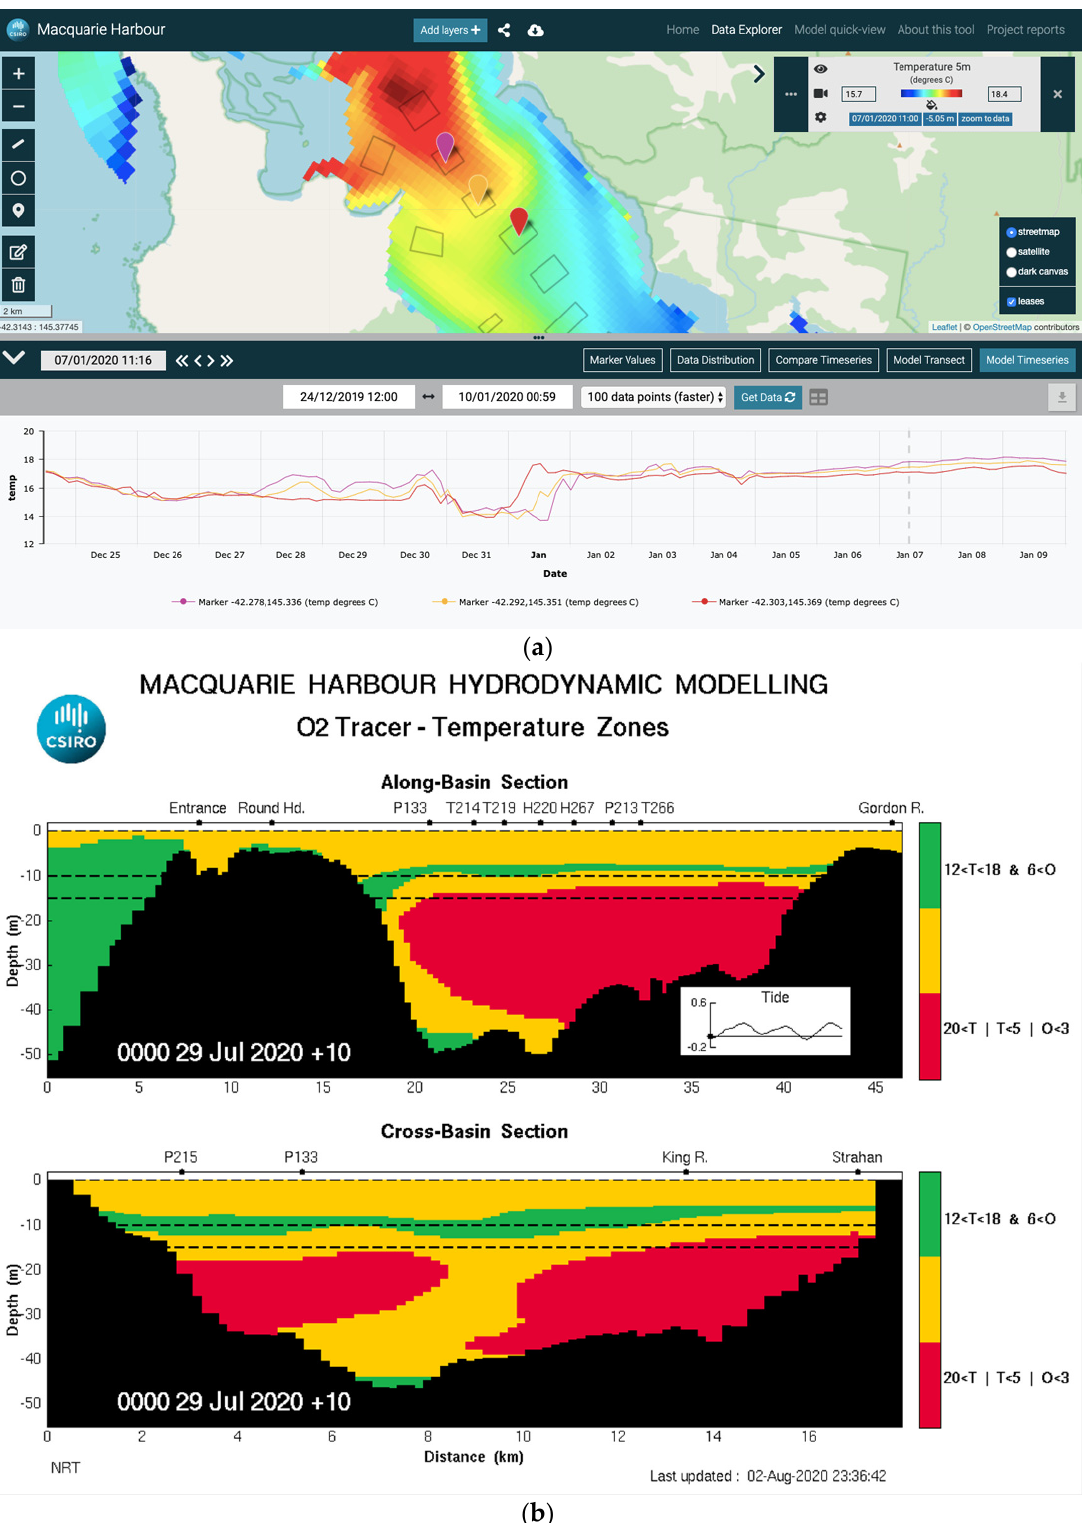
Figure 4. Interactive dashboard of model results displays: ( a ) depth layer and timeseries of dissolved oxygen concentration at sites of interest in Tasmania’s Macquarie Harbour; ( b ) depth resolved transects of modelled water quality suitable for salmonoids [favourable—green;